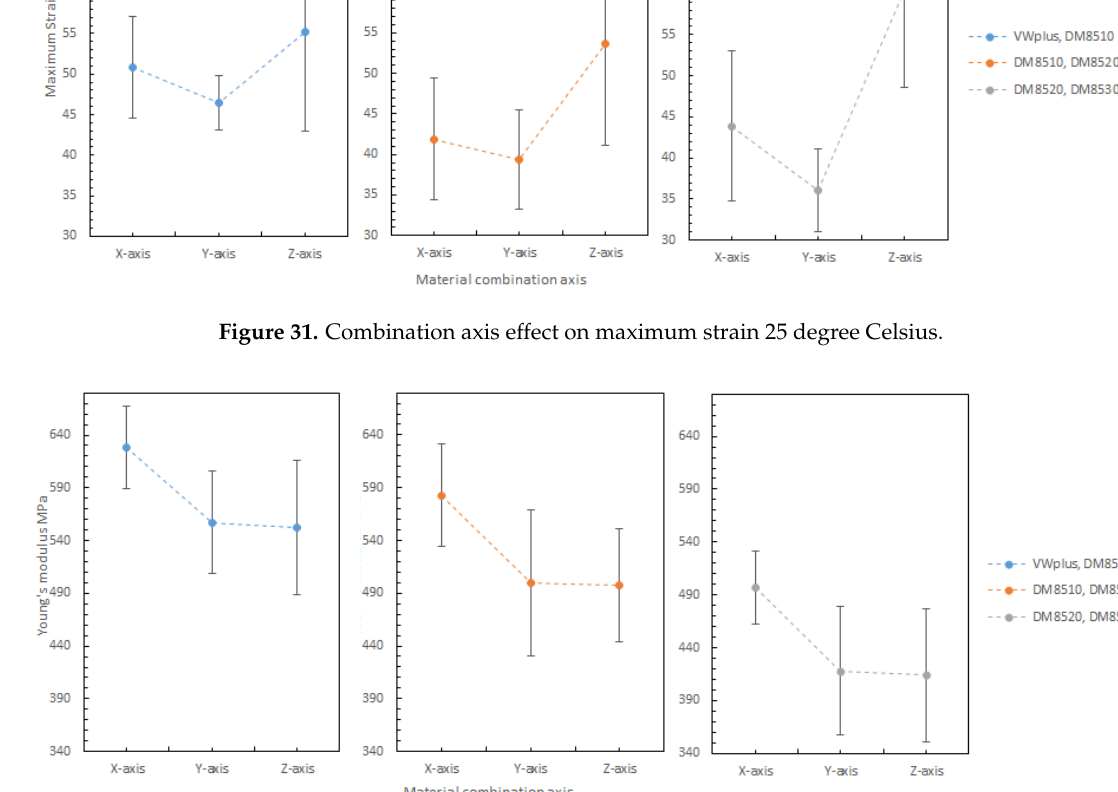
Figure 32. Combination axis effect on Young’s Modulus 25 degree Celsius.